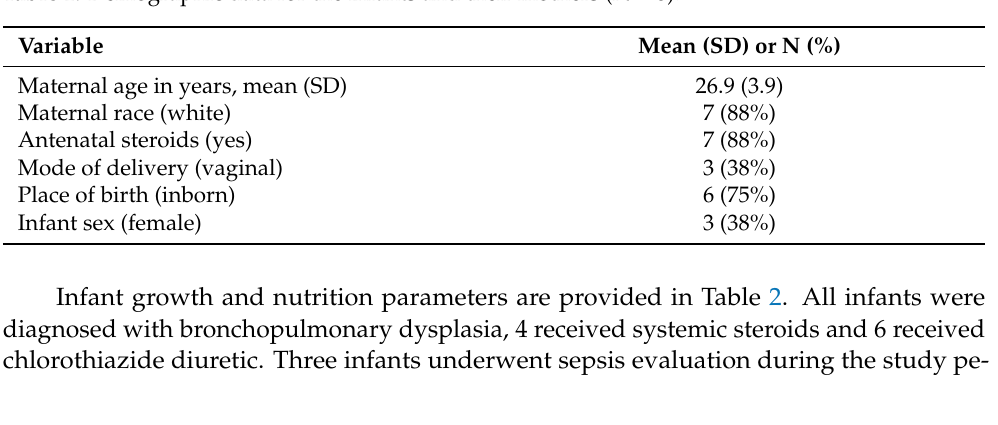
Table 1. Demographic data for the infants and their mothers (N =